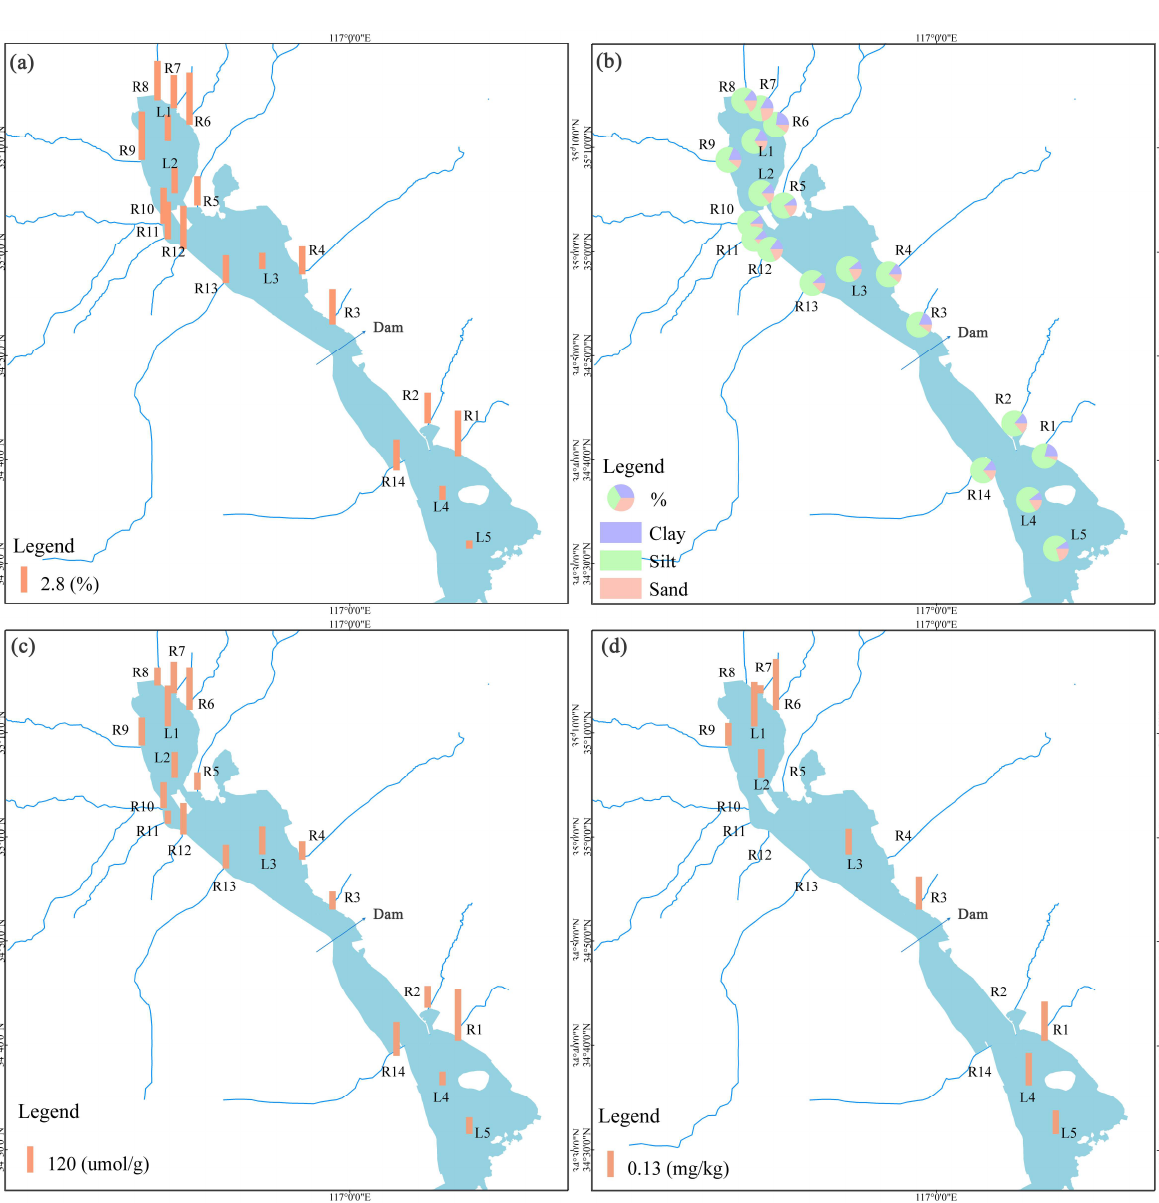
Figure 2. Spatial distribution of basic properties of sediment including ( a ) the total organic carbon (TOC) content, ( b ) the sediment grain composition, ( c ) the acid volatile sulfide (AVS) content, and ( d ) the total sulfide (TS) content.